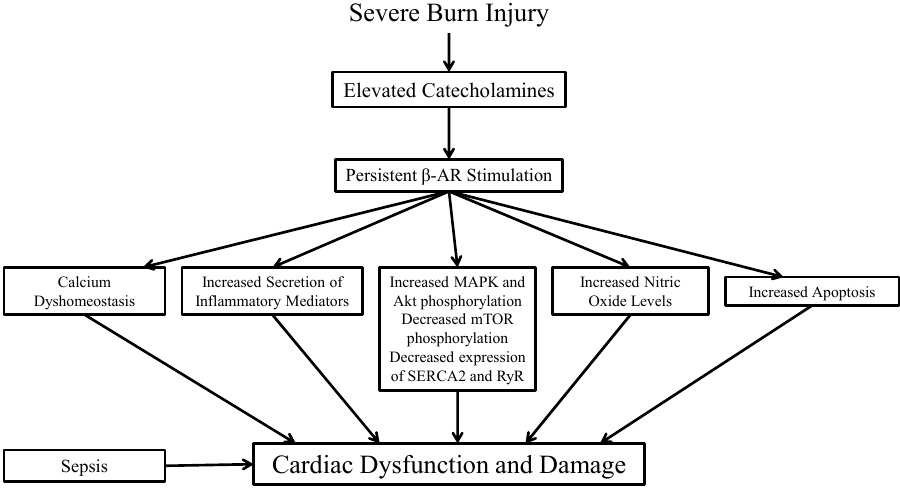
Figure 1. Schematic of the signaling changes that are postulated to occur downstream of β -adrenergic receptor ( β -AR) stimulation following burn injury. MAPK, mitogen-activated protein kinase; Akt, protein kinase B; mTOR, mammalian target of rapamycin; SERCA2, sarcoplasmic reticulum calcium ATPase 2; RyR, ryanodine receptor.